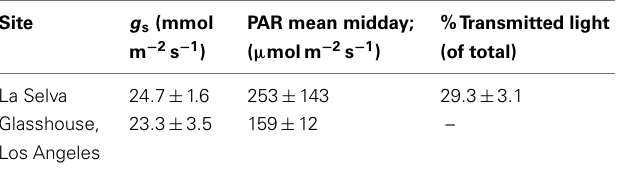
Table 1 | Stomatal conductance ( g s ) and light environments for G. lingulata.